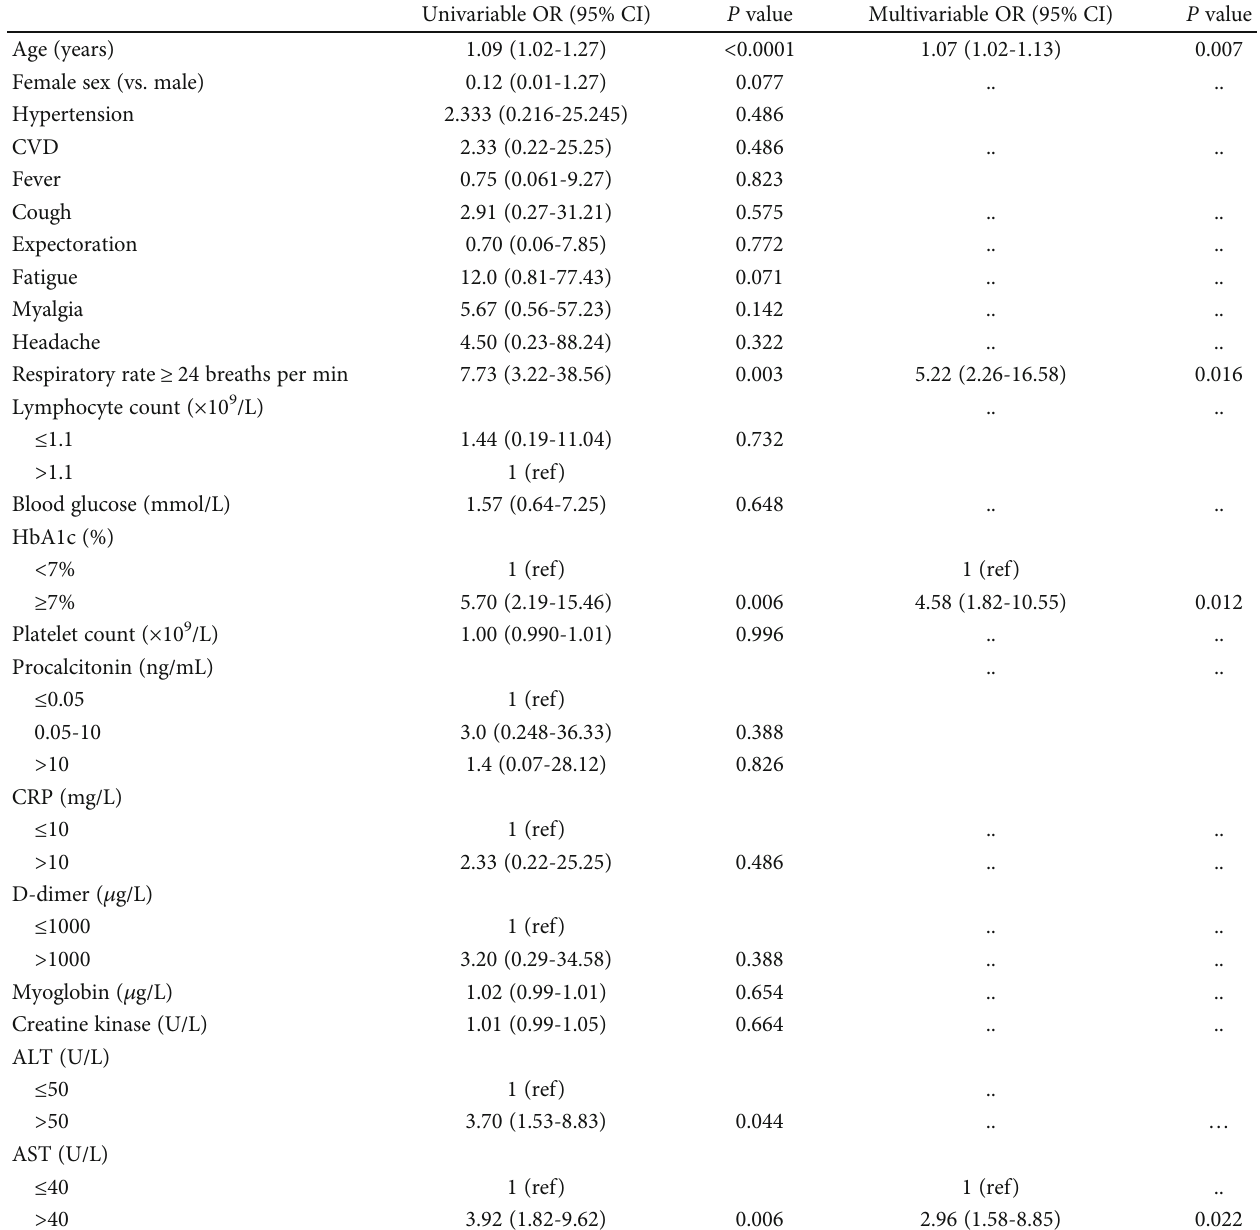
Table 3: Risk factors of ICU admission for COVID-19 patients with